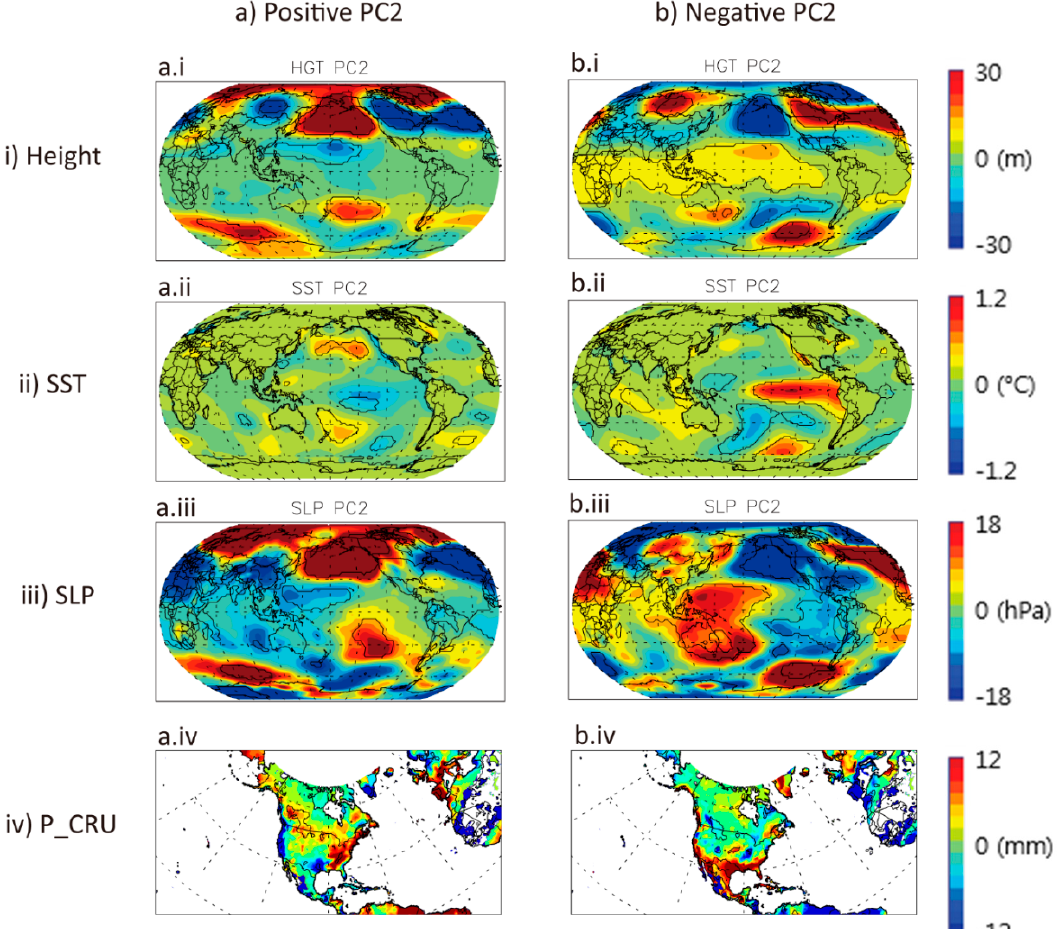
Figure 5. Composite anomaly fields of ( i ) HGT_500 (m), ( ii ) SST (°C), ( iii ) SLP (mb), and ( iv ) CRU precipitation (mm) of the positive and negative PC2 composite ( a , b , respectively) shown in Table 4. Black solid lines indicate statistical significance at the 95% confidence level.